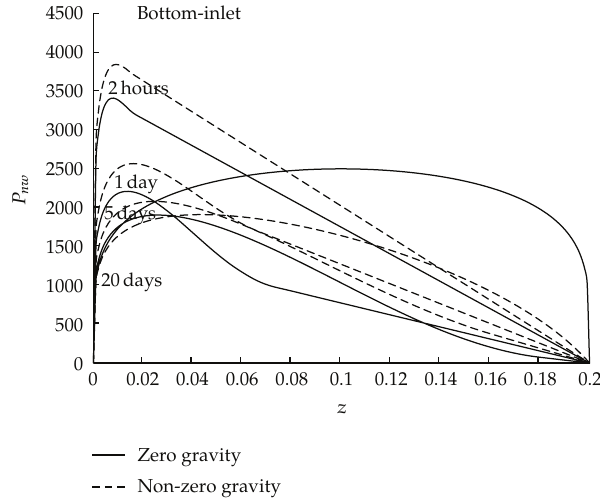
Figure 17: Comparison between considering and neglecting gravity e ff ect on oil pressure for the bottom- inlet case, at x (cid:8) 0 .